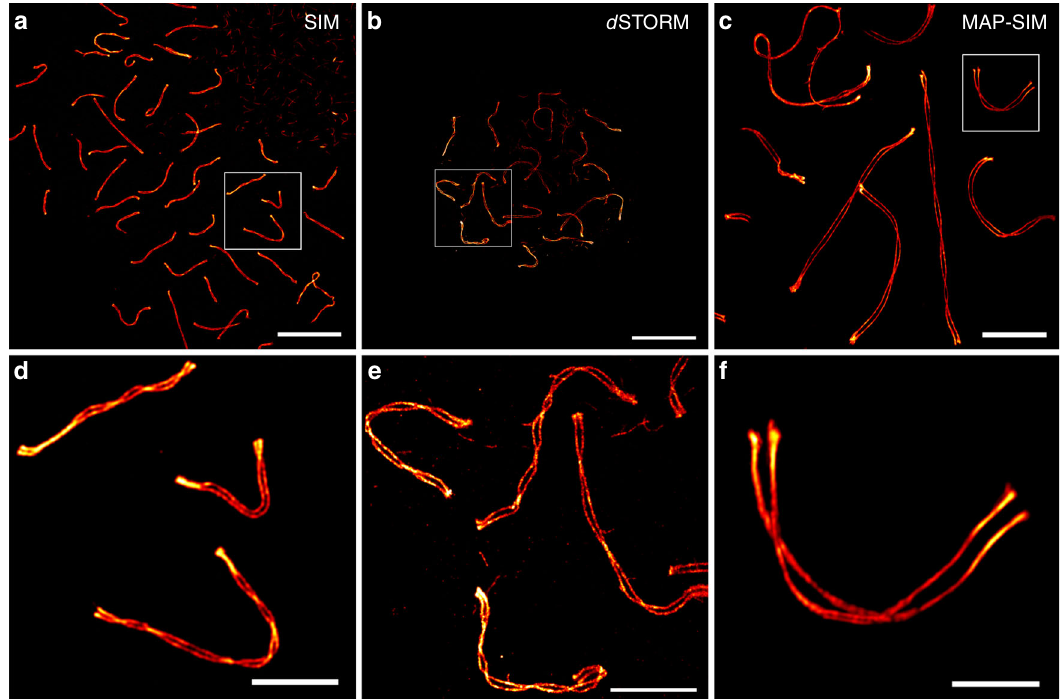
Fig. 2 Super-resolution imaging of the lateral element protein SYCP3. a SIM image of unexpanded SYCP3 labeled with Alexa Fluor 568. b d STORM image of unexpanded SYCP3 labeled with Alexa Fluor 647. c Expanded MAP-SIM SYCP3 signal (maximum intensity projection) labeled with SeTau647. d – f Magni fi ed views of boxed regions in a – c , respectively. The images indicate that MAP-SIM provides a similar labeling density and spatial resolution as d STORM of 20 – 30 nm in the imaging plane. Scale bars, a – c 10 µ m, d – f 3 µ